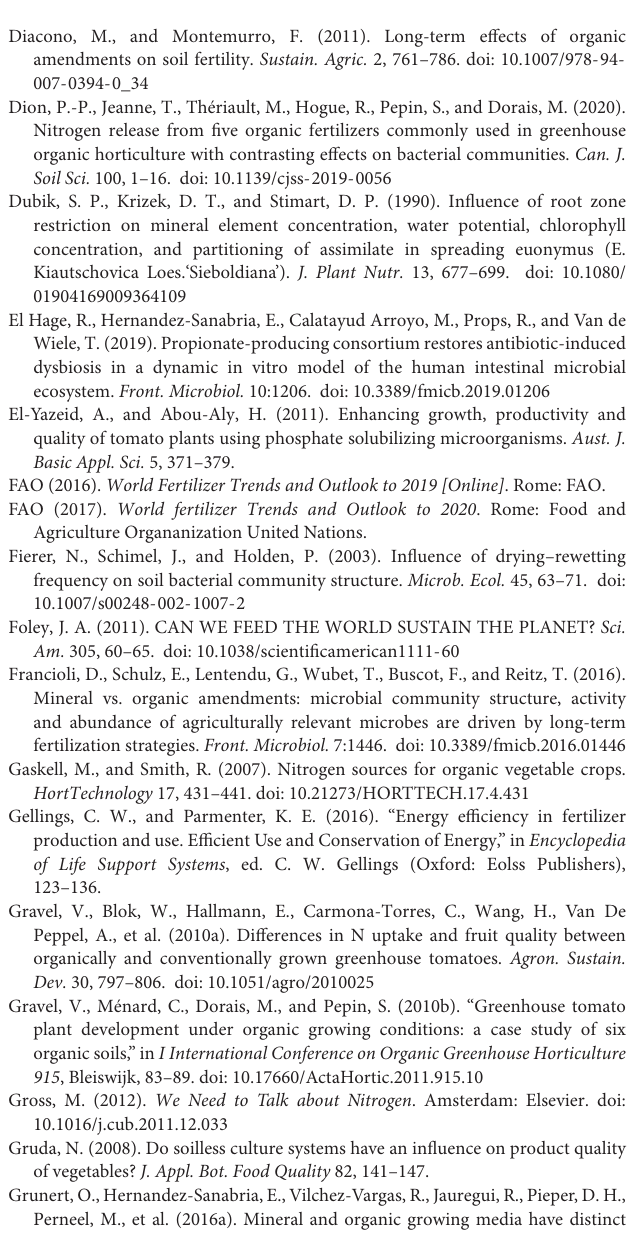
Supplementary Table 5 | Correlations between microbial community composition and chemical characteristics in four different tomato cultivating systems across time points. indicated by the Multiple Factor Analysis. Dimensions of the MFA can be described by the categorical variables included in the analysis. For each categorical variable (growing medium and time point). A one-way analysis of variance was performed with the coordinates of the samples on the axis. explained by the time point or growing medium type. Then, for each level of the category (i.e., time point 1. time point 2 or time point 3 or growing medium GB). A Hotelling T 2 -test was used to compare the average of the category with the general average (using the constraint P i α i = 0. α i = 0). For instance. the coordinates of the relative abundance of family “x” at GB at time point 1 were compared with the average coordinates of the relative abundance of family “x” in GB. The P - value associated to this test is transformed to a normal quantile to assess whether the mean of the category is significantly less or greater than 0. Negative values indicate negative